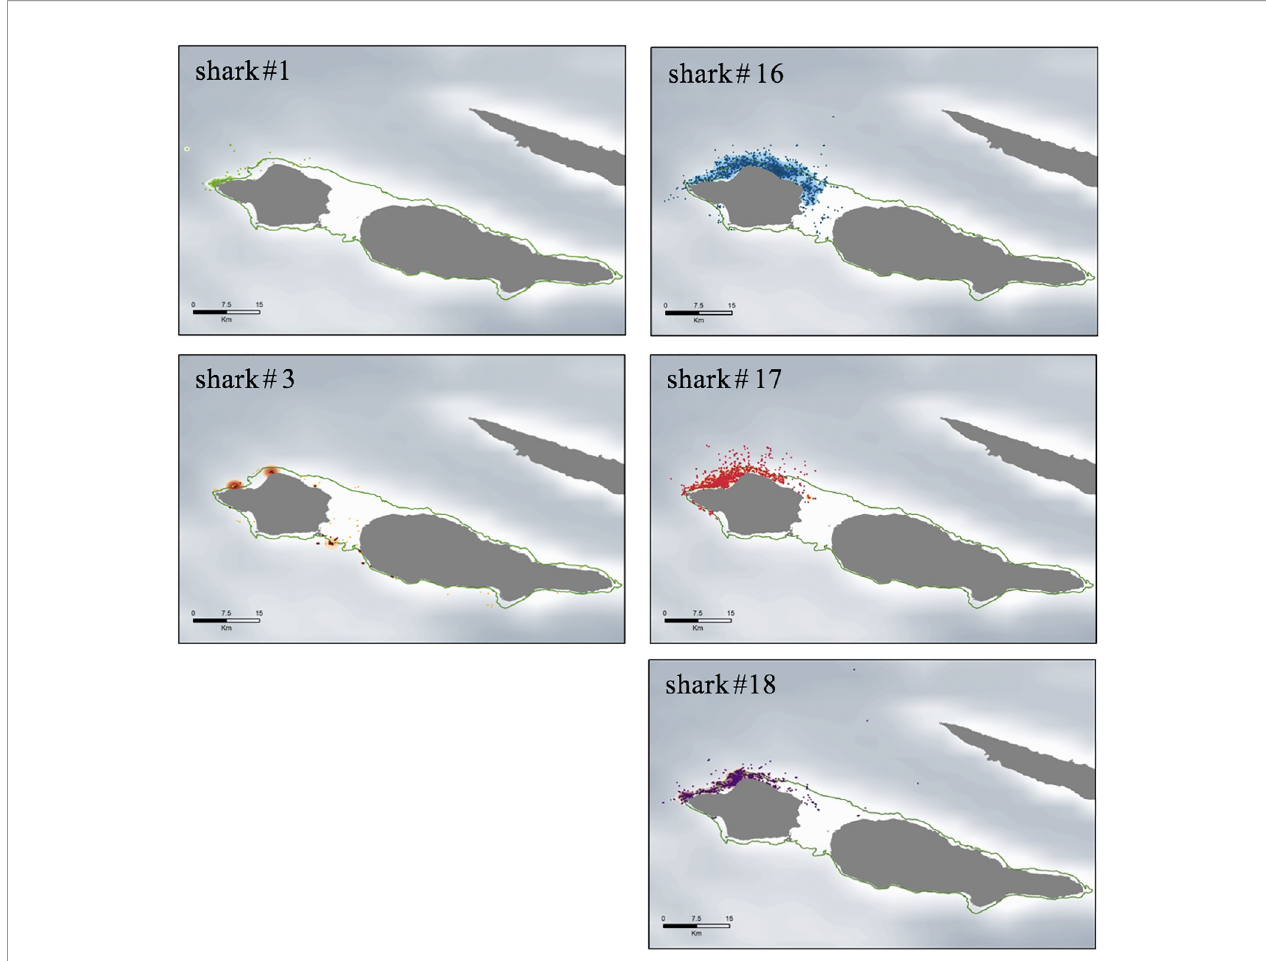
FIGURE 3 | The most probable positions estimated for fi ve SPOT satellite-tagged smooth hammerhead sharks ( Sphyrna zygaena ) around Faial and Pico islands; acoustic detections of double tagged individuals (#1 and #3) were used in improving the ARGOS estimates; shaded areas denote the kernel utilization distribution (KUD) home ranges.